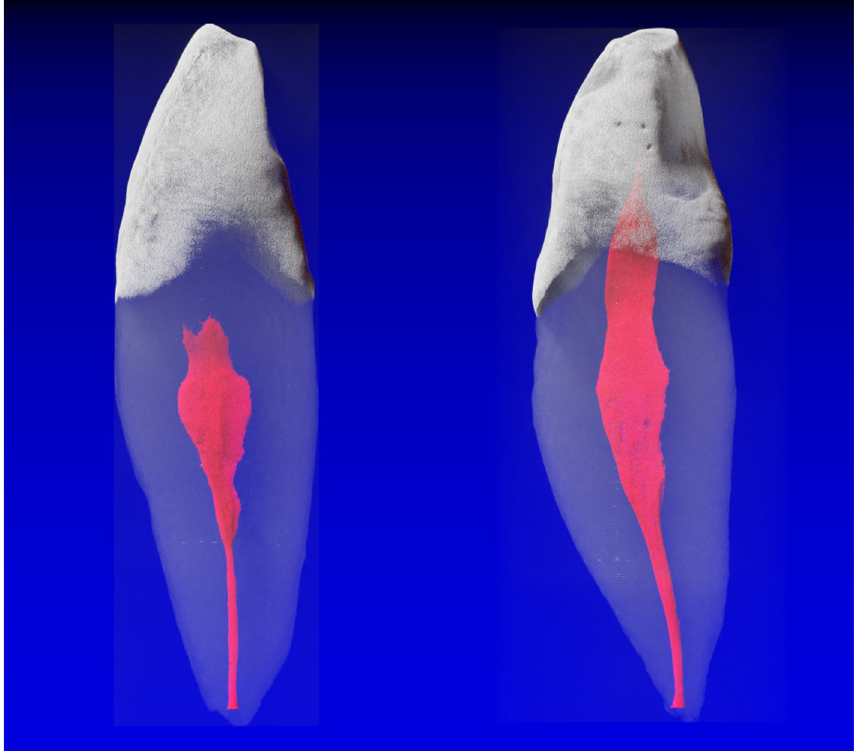
Figure 1. Mandibular canines with a 1-1-1/1 root canal configuration. The root canals observed were most of the time wide (in a mesio-distal projection); however, the tended to narrow as they reached the apical